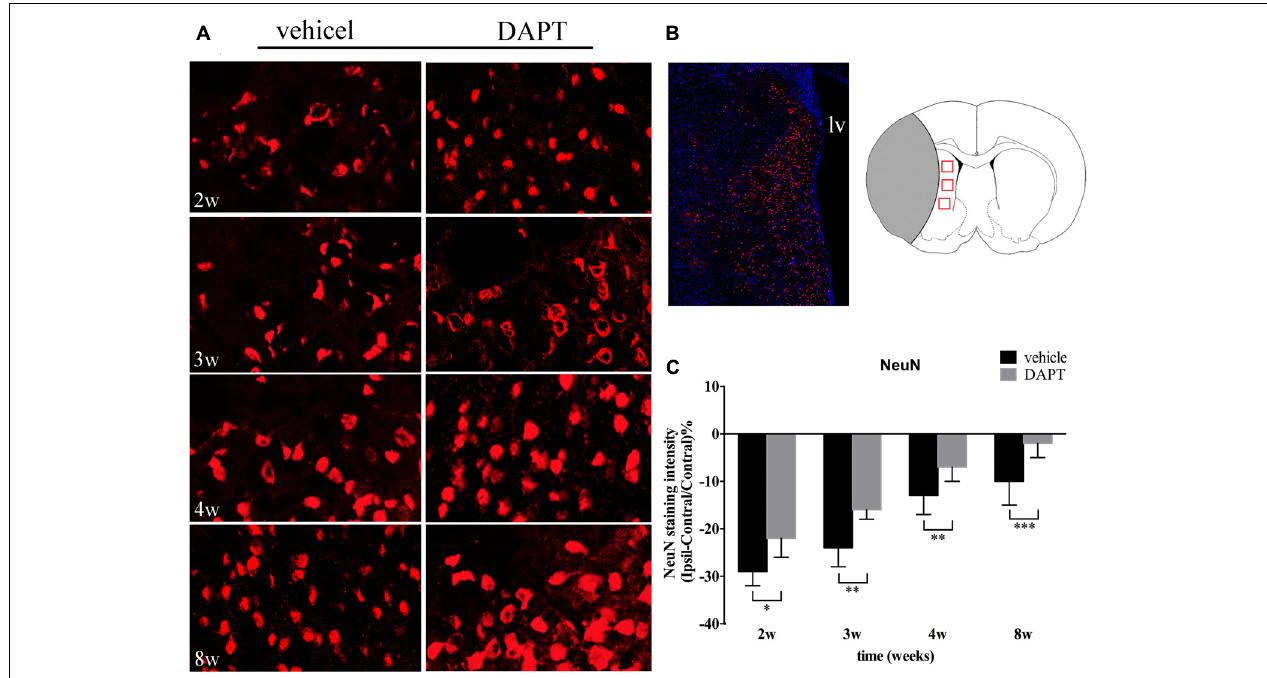
FIGURE 8 | Effects of DAPT on mature neurons activity after MCAO. (A) Immunostaining of NeuN in ischemic boundary of STR in two group rats from 2 to 8w. Scale bar = 20 µ m. (B) The “photomerged” image shows the location of NeuN (+) cells in the ischemic boundary of STR. The anatomical reference shows the ROIs. Scale bar = 100 µ m. (C) Comparisons of NeuN fluorescence intensity in two group rats. ∗ P < 0.05, 2w; ∗∗ P < 0.01, 3w, 4w; ∗∗∗ P < 0.001, 8w versus DAPT and